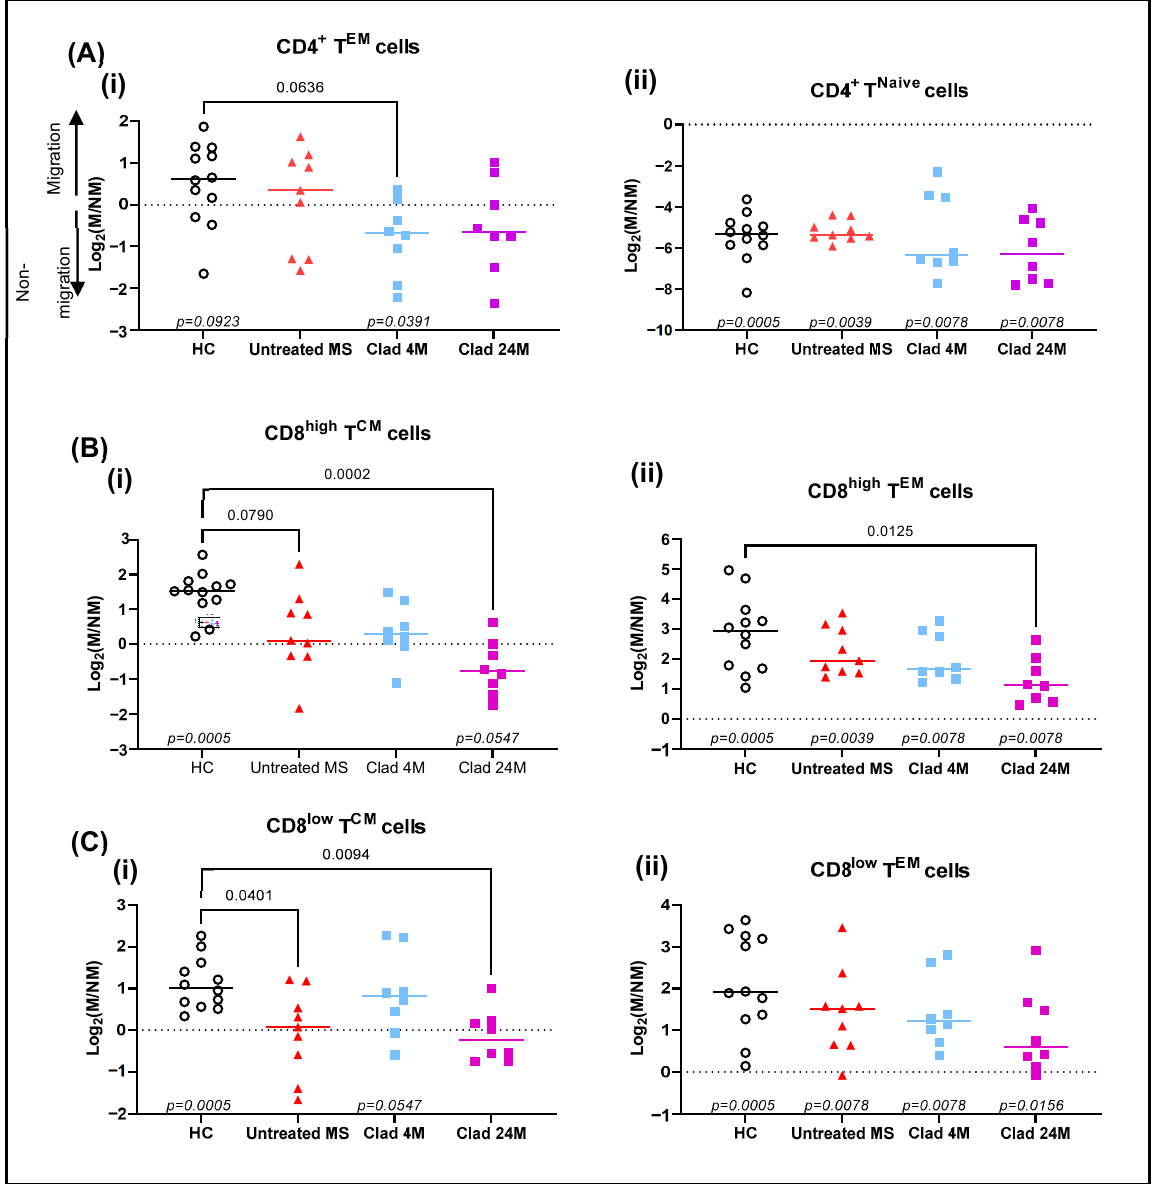
Figure 1. Cladribine inhibits the migration of CD4 + T EM cells and CD8 + T CM cells across the BBB in vitro. PBMC were isolated from healthy controls ( n = 12), untreated MS ( n = 9) and cladribine-treated MS patients at 4 months ( n = 8) and 24 months ( n = 8) post initial dose. PBMC were then added to an in vitro model of the stimulated BBB and left to migrate overnight. The logarithm of 2-fold change of migrated to non-migrated cells was calculated. ( A ) The migratory capacity of ( i ) CD4 + T EM cells and ( ii ) CD4 + T Naïve cells. ( B ) The migratory capacity of ( i ) CD8 high T CM cells and ( ii ) The CD8 high T EM cells. ( C ) The migratory capacity of ( i ) CD8 low T CM cells and ( ii ) CD8 low T EM cells. In-group analysis performed using one sample Wilcoxon matched-pairs signed rank test with the Pratt method with p -values ≤ 0.1 displayed at the bottom of each graph. Between-group analysis performed using Kruskal–Wallis with Dunn’s multiple comparisons test. Median shown. NM, non-migrated; M, migrated; T CM , central memory T cells; T EM , effector memory T cells; T Naive , naïve T cells; HC healthy controls; MS, multiple sclerosis; BBB, blood–brain barrier; Clad, cladribine; 4M, 4 months post-Clad; 24M, 24 months post-Clad; PBMC, peripheral blood mononuclear cells. CD49d expression was higher on migrated CD4 + T EM and CD8 high and CD8 low T CM cells compared to non-migrated cells (Figure 2(Ai–Aiii)). For migrated CD4 + T EM cells, CD38